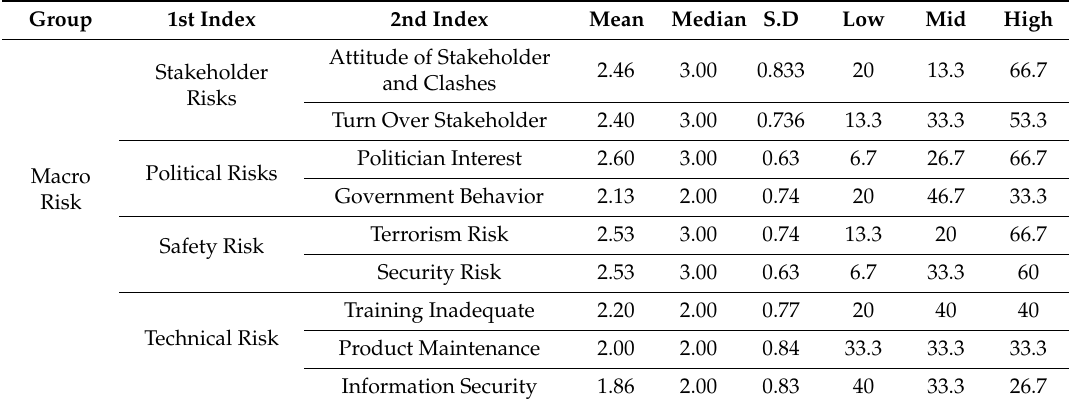
Table 6. Macro-level risk for round 2.